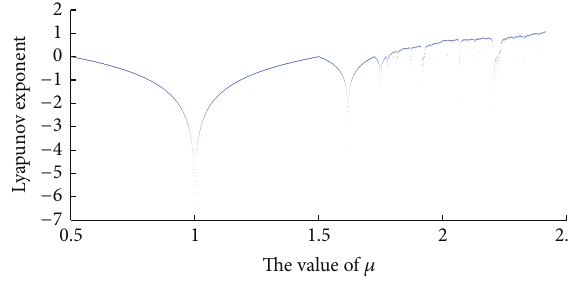
Figure 4: Lyapunov exponent spectrum of the new map.